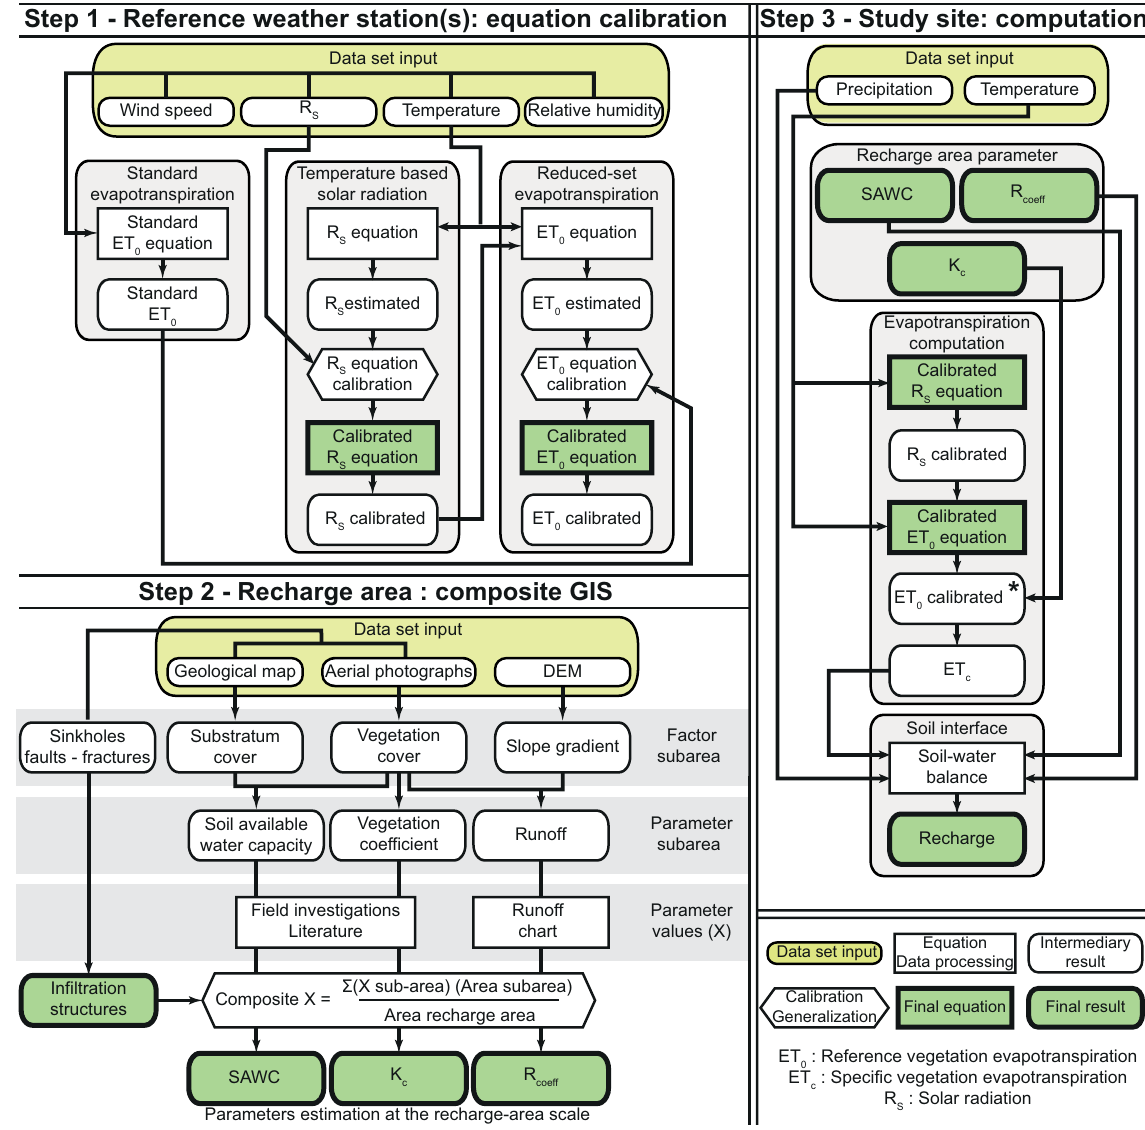
Figure 1. LRIW diagram. Step 1: calibration of standard ET 0 and R S methods. Step 2: estimation of recharge-area parameters required for the soil-water balance ( R coeff , K c and SAWC) and the infiltration structures. Step 3: computation of the recharge with the soil-water balance. ∗ In the case of a landslide-located weather station recording the full set of parameters, the first step can be skipped and the ET